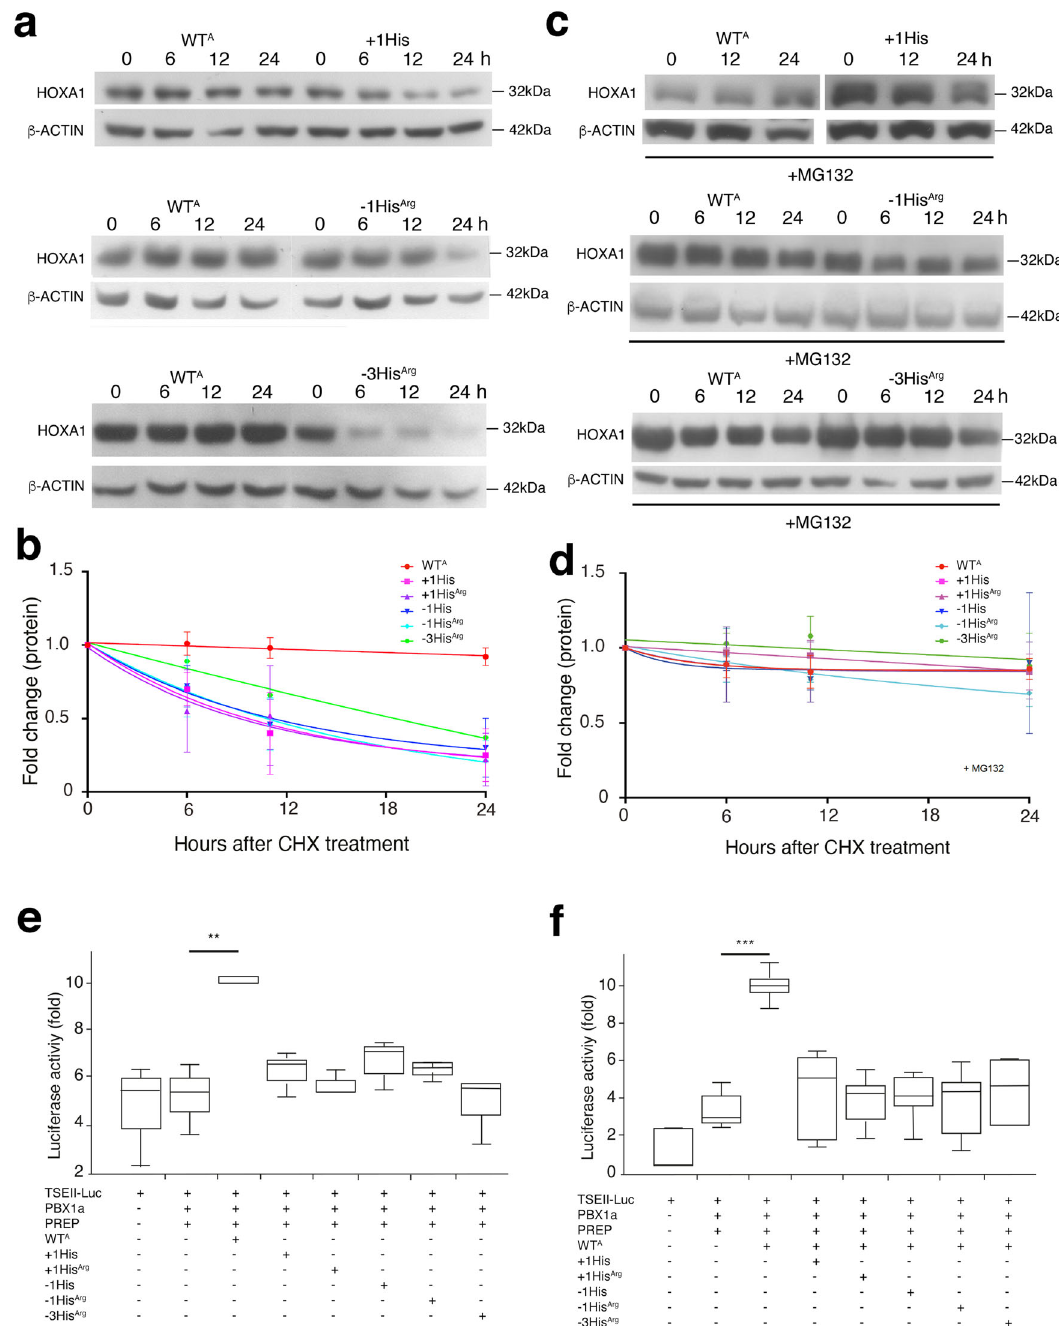
Fig.2| HOXA1 variantsinduceproteasome-dependentproteindegradationand reduce transcriptional activity of the protein. a – d HEK293T cells were trans- fectedwithexpressionvectorscodingforFLAG-HOXA1(WT A ,+1His,+1His Arg , − 1His, − 1His Arg and − 3His Arg ). To determine the half-life of HOXA1, cells were treated with cycloheximide (CHX; 200 μ g/ml) for the indicated time. a Cell lysates were col- lectedevery6handthensubjectedtoimmunoblotanalysiswithantibodiesagainst FLAG and β -ACTIN. b Intensity of the HOXA1 bands observed upon cycloheximide treatment was quanti fi ed and the relative HOXA1/ β -ACTIN ratios were plotted ( n =6; n indicates number of biologically independent experiments (cell trans- fected independently in different weeks). Error bars indicate standard deviation (SD). c Involvement of the proteasome in the HOXA1 degradation was assayed by treating cells with proteasome inhibitor (MG132; 7 μ M) for 20h prior inhibition of protein translation with CHX ( n =3). Cell lysates were collected every 6 or 12h and then subjected to immunoblot analysis with antibodies against FLAG and β -ACTIN. d The intensity of the HOXA1 bands observed upon cycloheximide treatment was